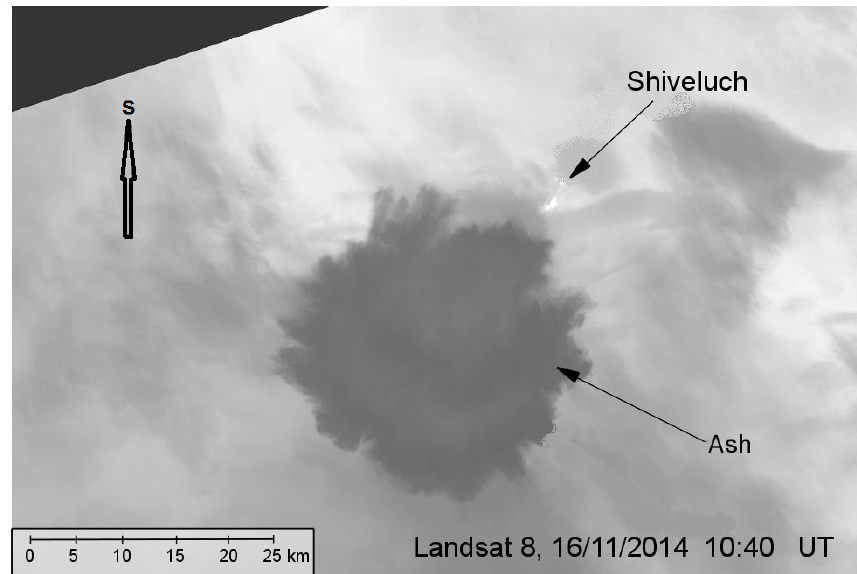
Figure 4. Satellite image (Landsat 8) of the eruptive cloud, at 10:40UT on 16 November 2014.